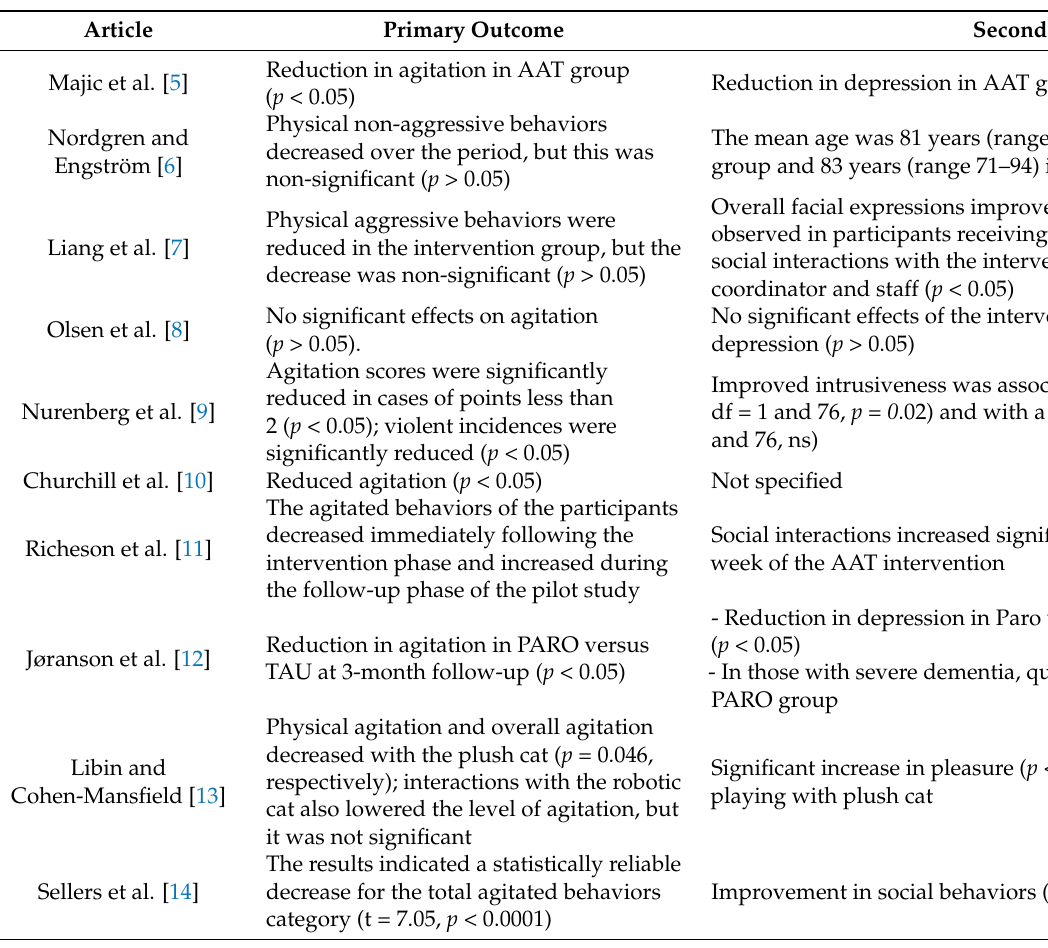
Table 2. Primary and secondary outcomes of studies